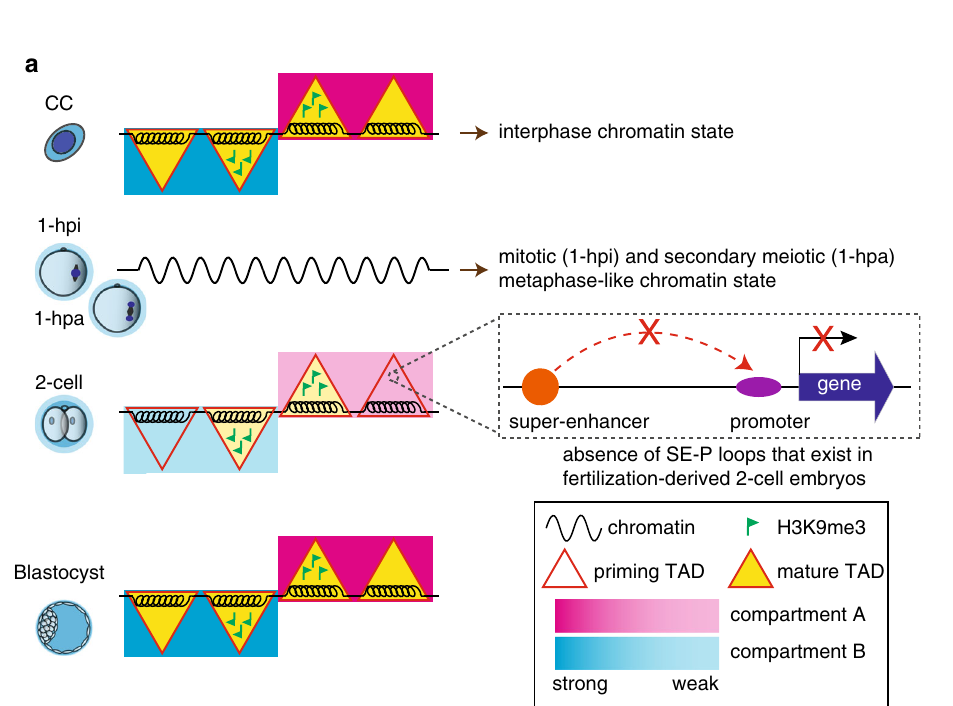
Fig. 6 H3K9me3 is a potential barrier of TADs reprogramming. a Heatmaps of chromatin interaction frequencies showing a CC TAD unreprogrammed example (magenta) and a CC TAD reprogrammed (cyan) example during SCNT embryo development. The bottom track shows the H3K9me3 signal in CCs. b RTIs of H3K9me3-maked and H3K9me3-unmarked TADs identi fi ed in CCs. RTI values in CC, 6-hpa, 12-hpa and early-2-cell embryos are shown ( n = 2184). Boxes show 25th, 50th and 75th percentiles and whiskers show 1.5× the inter-quartile range. The two-sided p values were calculated by the Kruskal – Wallis test with Dunn ’ s multiple comparison test and adjusted by default with the holm method. Source data and exact p-value are provided as a Source Data fi le. c Heatmaps showing normalized chromatin interaction frequencies (100-kb bin, chromosome 16) in SCNT, SCNT with Kdm4d mRNA injection, SCNT with TSA treatment and fertilization-derived early 2-cell embryos. Both ICE and Binless normalization approaches are used. d RTIs of H3K9me3-maked TAD in early 2-cell embryos. RTI values in CC, SCNT, SCNT with Kdm4d mRNA injection, SCNT with TSA treatment and fertilization- derived are shown ( n = 2184). Boxes show 25th, 50th and 75th percentiles and whiskers show 1.5× the inter-quartile range. The two-sided p values were calculated by the Kruskal – Wallis test with Dunn ’ s multiple comparison test and adjusted by default with the holm method (N.S., not signi fi cant). Source data and exact p-value are provided as a Source Data fi le. e Virtual 4C test showing the interaction frequencies between Zscan4d promoter and its adjacent region in chromosome 7. Black dots represent observed values, red line represents fi tted value by Binless.